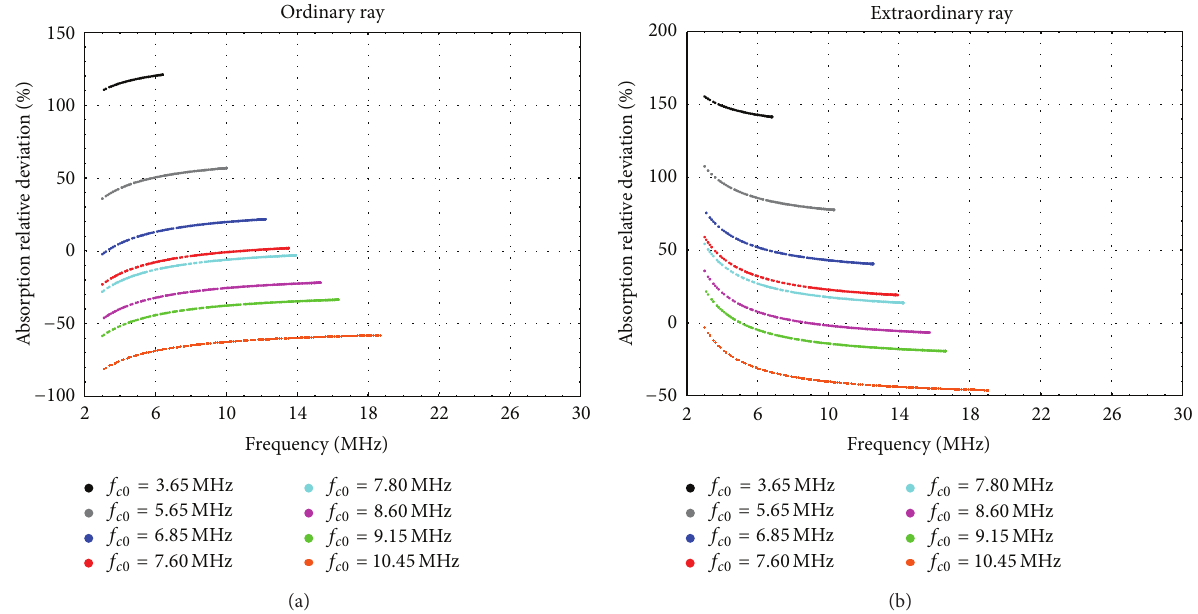
Figure 3: Plots of the QL nondeviative amplitude absorption [dB], according to the Settimi et al. [11] complex eikonal model (32), (33), and (34) and Rawer’s [12] theory (20a)-(20b), as a function of the frequency 𝑓 (MHz), for both the ordinary and extraordinary rays. The critical frequency 𝑓 𝑐0 at equator assumes the following values: (a) 𝑓 𝑐0 = 3.65 MHz, (b) 𝑓 𝑐0 = 5.65 MHz, (c) 𝑓 𝑐0 = 6.85 MHz, (d) 𝑓 𝑐0 = 7.60 MHz, (e) = 7.80 MHz, (f) 𝑓 = 8.60 MHz, (g) 𝑓 = 9.15 MHz, and (h) 𝑓 = 10.45 MHz. 𝑓 𝑐0 𝑐0 𝑐0 𝑐0